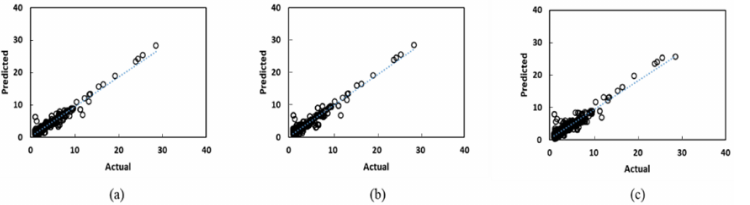
Figure 10. Proxy results charts for revenue (mm USD) where ( a ) Stacked learner; ( b ) AdaBoost; ( c ) Random Forest. The ordinate refer to the proxy predictions and the abscissa refer to the numerical simulation